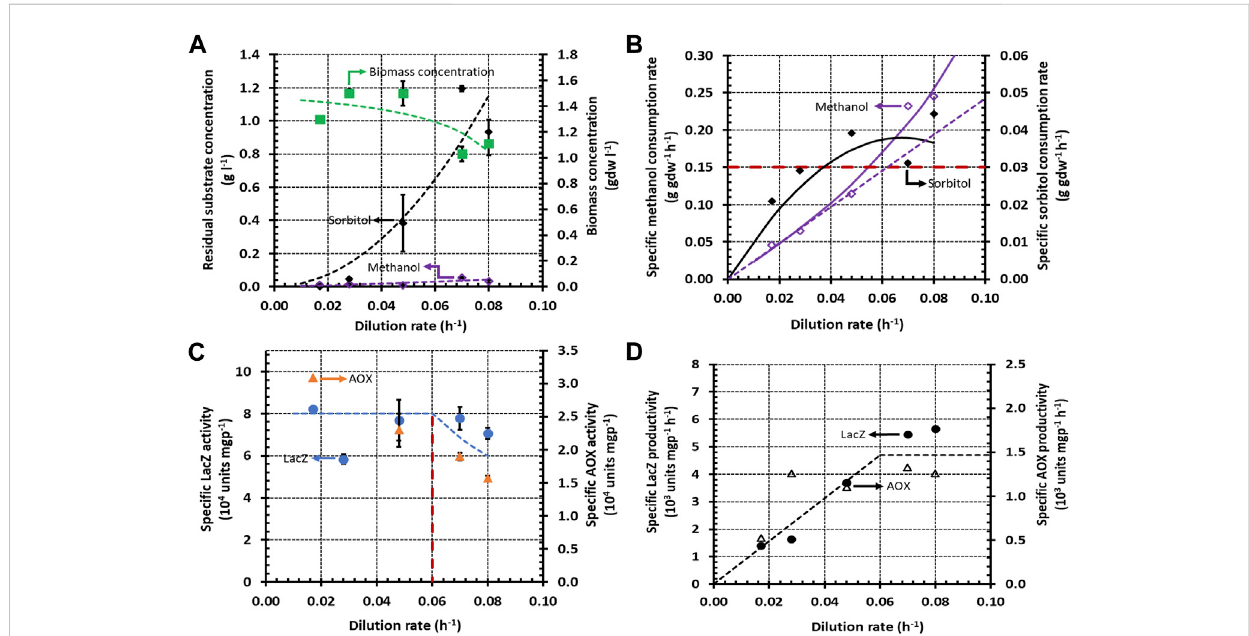
FIGURE 3 Variation of steady state concentrations with the dilution rate during growth of K. phaf fi i strain Mut + (pSAOH5-T1) in a chemostat fed with a mixture of sorbitol (~1.5 g L − 1 ) and methanol (~3.2 g L − 1 ). (A) Concentrations of biomass, residual sorbitol and residual methanol. (B) Speci fi c methanol and glycerolconsumptionratescalculatedfromthedatain (A) usingEq.5.Thedashedlinepassingthroughtheoriginshowsthelinearincreaseofthespeci fi c methanol consumption rate in the dual-limited regime. The horizontal dashed line shows the threshold speci fi c methanol consumption rate of